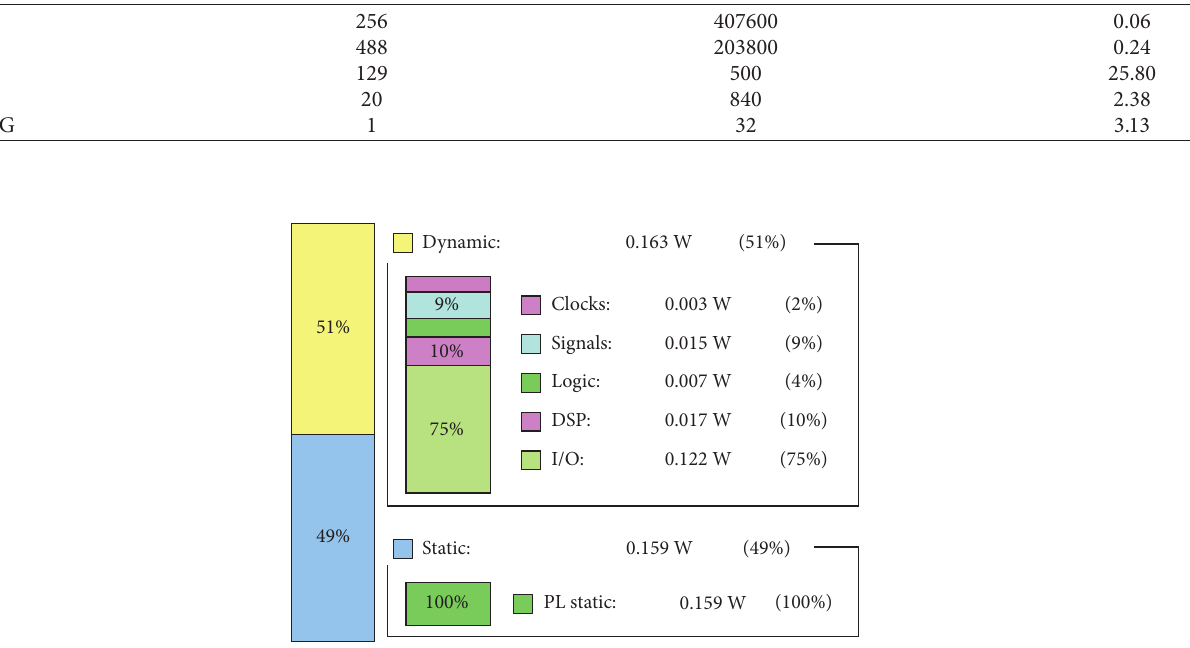
Figure 20: Power consumed for the FPGA implementation of memristive hyperjerk chaotic system (1). Table 3: Resource utilization for the FPGA implementation of memristive hyperjerk chaotic system.